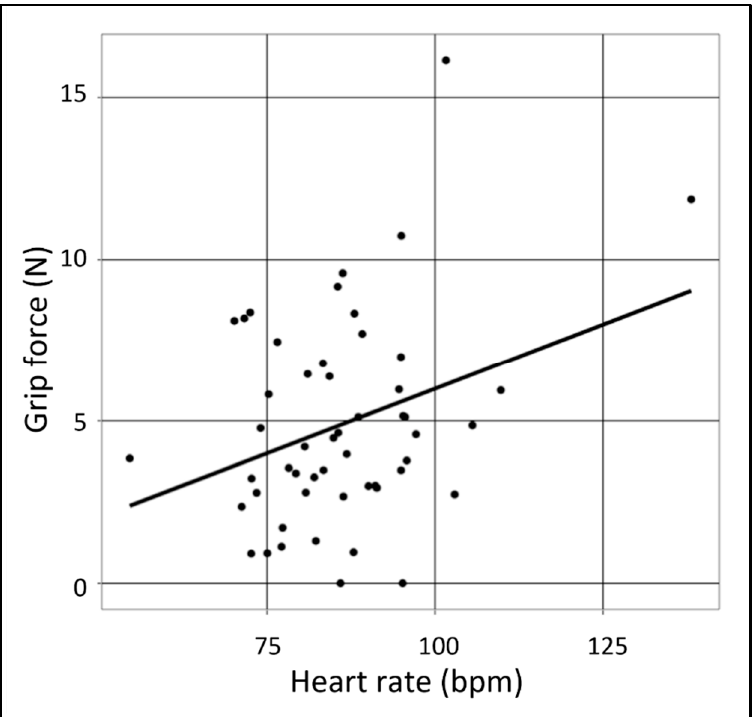
Figure A1. Grip force as a function of heart rate. The plot illustrates the significant correlation where X-axis values represent the mean heart rate (bpm), and the Y-axis values represent mean grip force (N). Dots represent individual observations (each participant’s values). Line represents smoothed conditional means using lm smoothing.